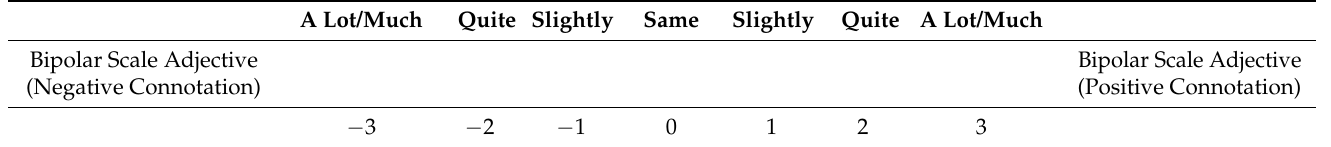
Table 3. Seven-point bipolar